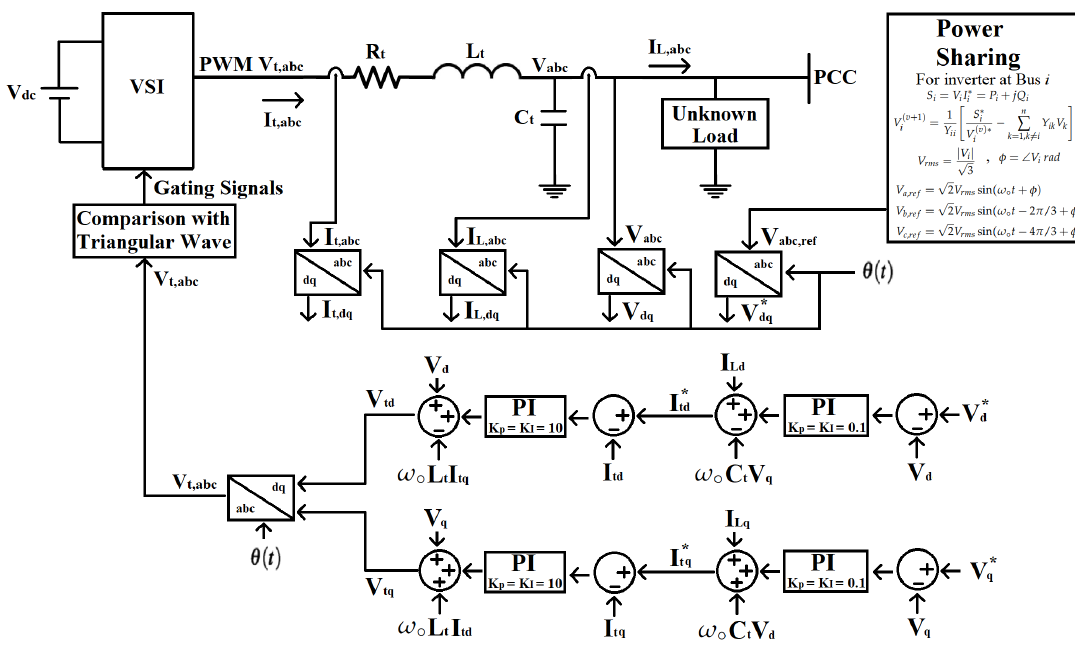
Figure 9. PI-based control scheme applied to the VSI voltage